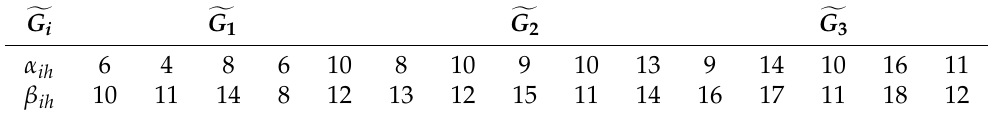
Table 3. Position-dependent weights.